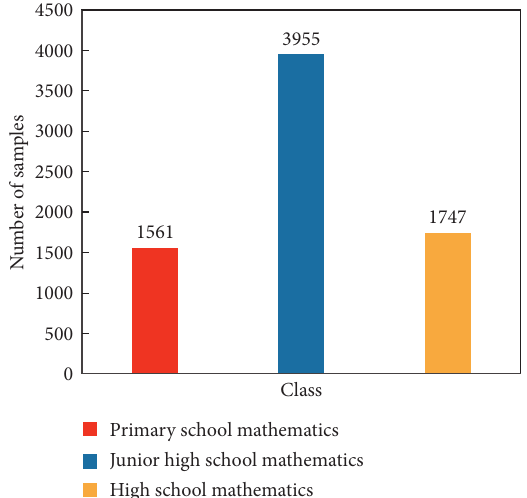
Figure 4: Distribution of samples.